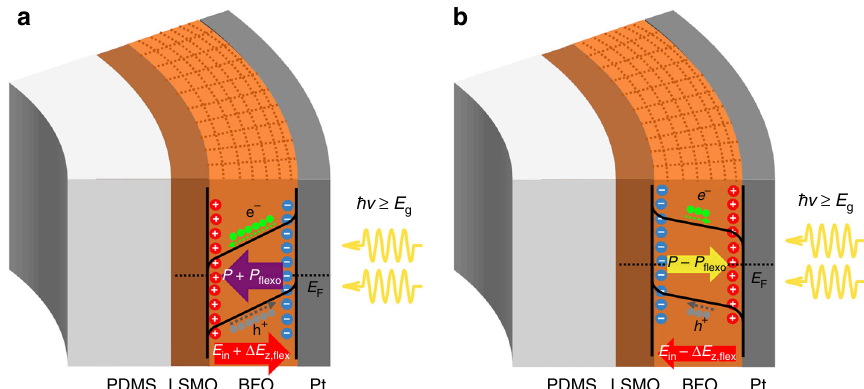
Fig. 5 Tunable band diagram across the device by the fl exoelectric effect. The band bending diagram of BFO fi lm at bent status with a downward polarization toward LSMO and b upward polarization toward Pt. Flexoelectric polarization P fl exo points downward. When ħ v ≥ E g of BFO, electron – hole pairs will be separated by the internal built-in fi eld ( E in ). The additional electric fi eld ( Δ E z, fl exo ) generated by the fl exoelectric fi eld will enhance or weaken the photovoltaic effect depending on the BFO polarization